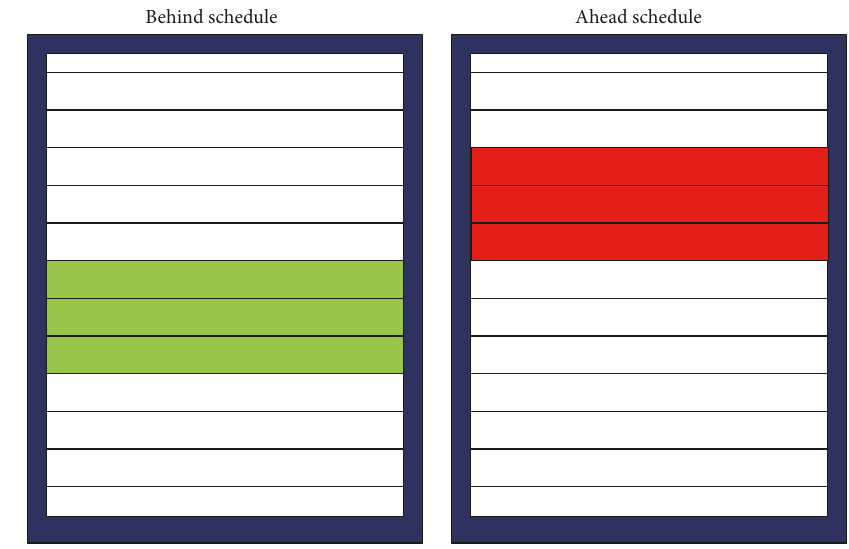
Figure 1: Cruising guidance on-board device surface (adapted from [9]